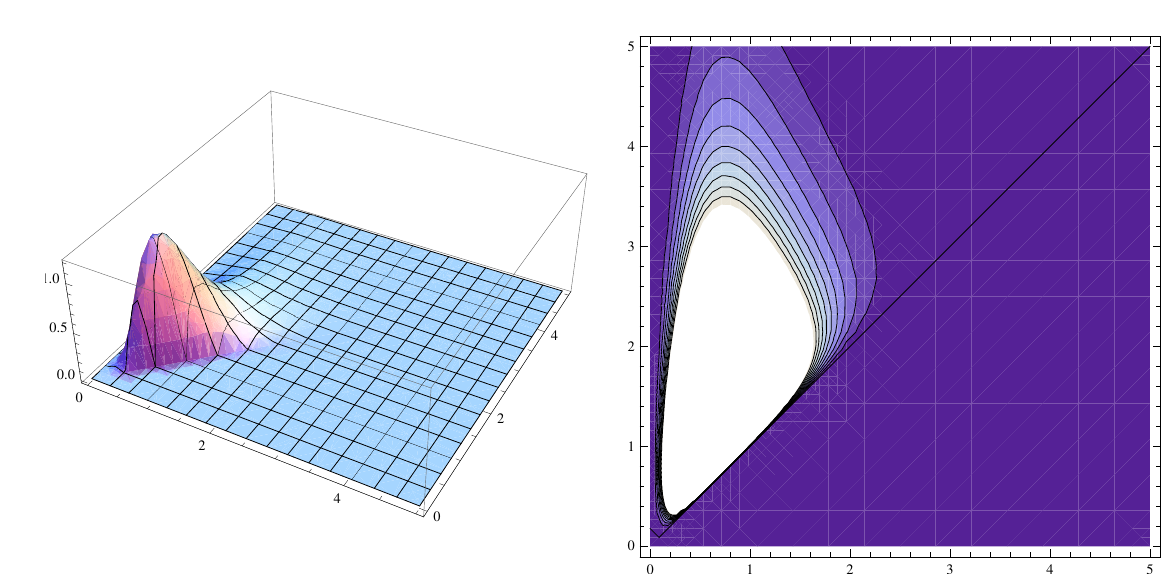
Figure 1. Joint pdf and contour plots of the Bivariate GB2 distributions with support above than diagonal, with σ i = 1, i = 1,2 and p i = 2, i =